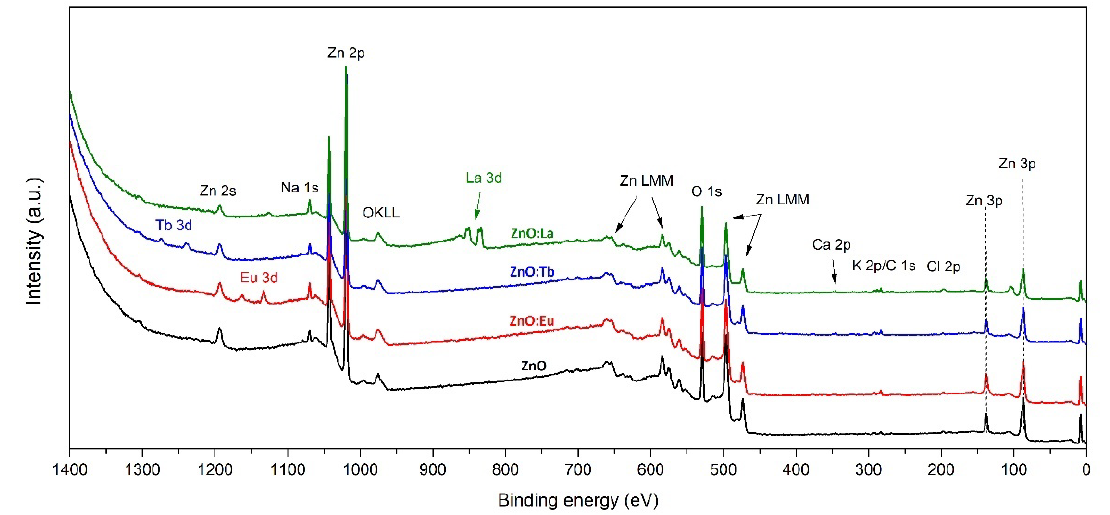
Figure 4. XPS spectra of Eu-, Tb-, and La-doped ZnO; and undoped ZnO. Table 2. Elemental composition of ZnO, ZnO:Eu, ZnO:Tb and ZnO:La samples. Elemental Composition (at%)